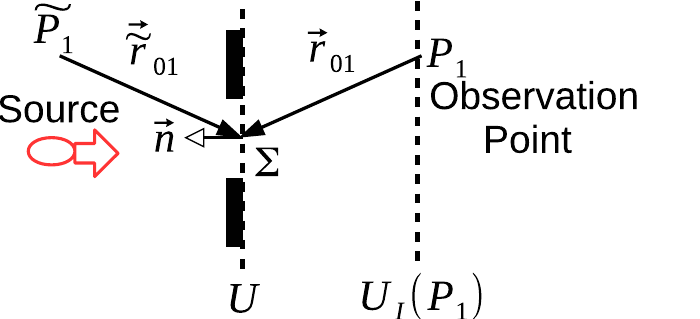
Figure 11. Formulation set-up for first type of solution of Rayleigh–Sommerfeld diffraction through a slit (cid:31) 77 .